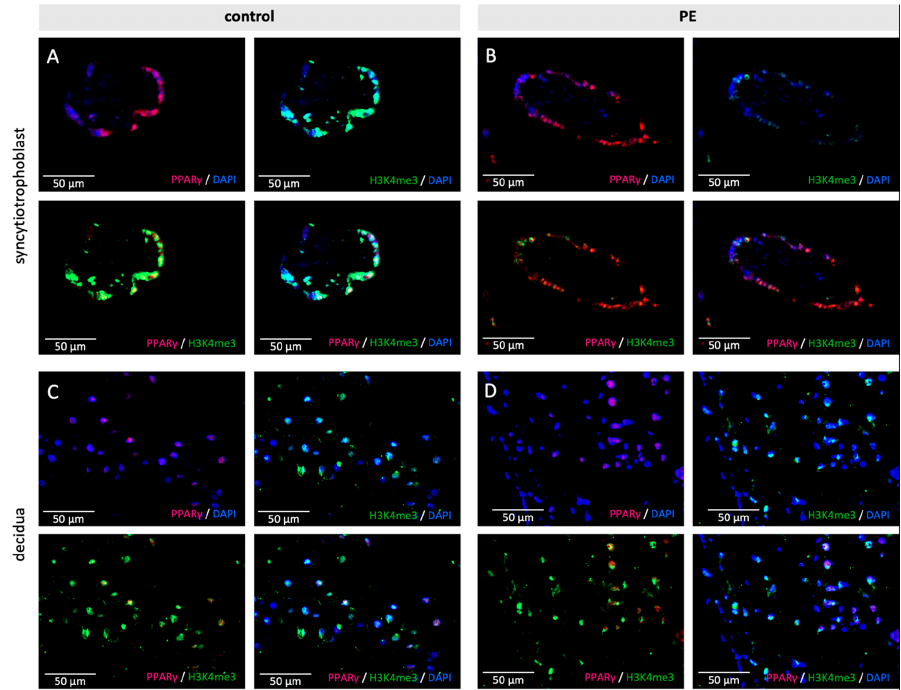
Figure 5. Examples of staining results of the immunofluorescence of PPAR γ and H3K4me3 in control ( A , C ) and PE placentas ( B , D ) in the syncytiotrophoblast ( A , B ) and the decidua ( C , D ). Single immunofluorescence staining of PPAR γ (pink) and H3K4me3 (green). Double immunofluorescence staining of H3K4me3 and PPAR γ (yellow). DAPI as nucleus staining (blue). Scale bar 50 µ